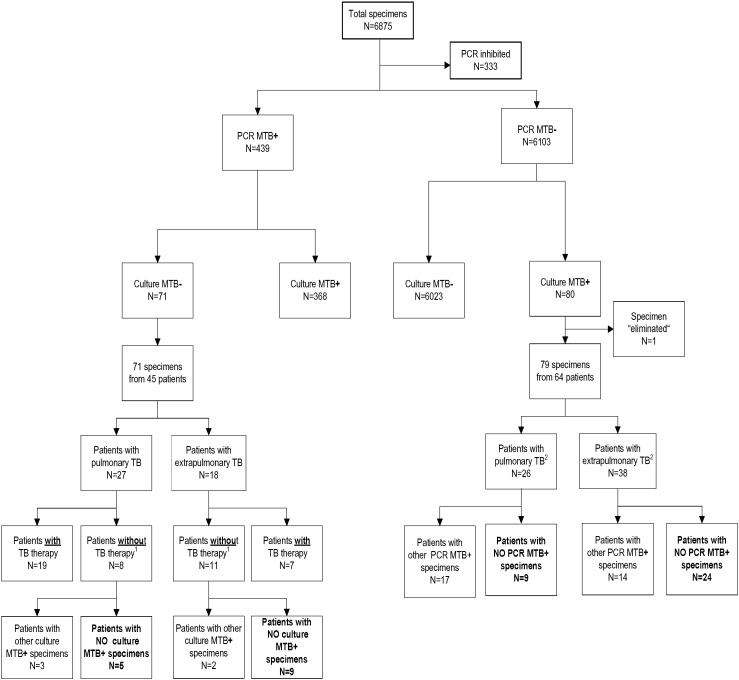
Workflow of clinical specimens studied using the COBAS™ TaqMan™ MTB assay.Abbreviations: MTB: Mycobacterium tuberculosis; TB: tuberculosis.1For details: see Table S4 in the Supplemental materials.2For details: see Table S5 in the Supplemental materials.